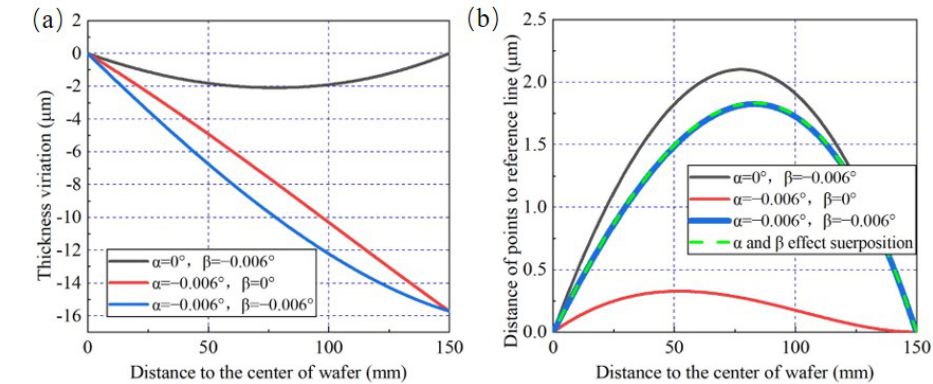
Figure 10. The verification to the superposition characteristics of δ 2 , under the combination of α and β (when β < 0). ( a ) Thickness variation simulation results. ( b ) The calculation results of the distance of points to the reference